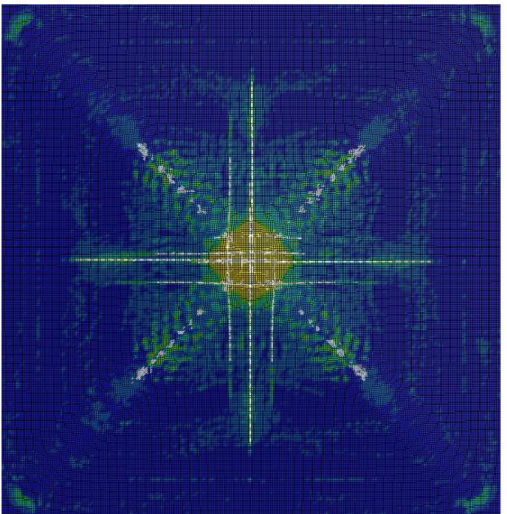
Figure 18. Assumed damage to batch of specimens A2, made from SFRC, based on numerical simulation; cracks and deformation of the material ion the reverse side.